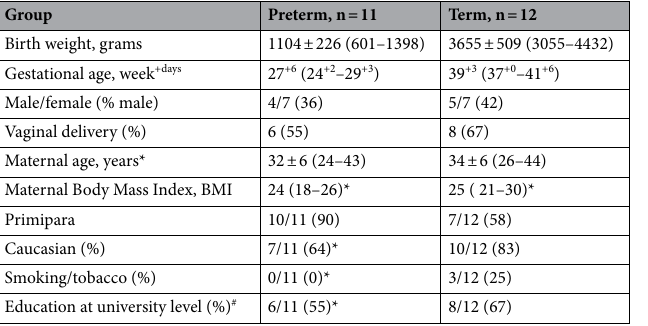
Table 1. Cohort characteristics. *Mean ± SD (minimum–maximum) if nothing else mentioned. # Data missing n = 1. # All mothers had at least 10–12 years of